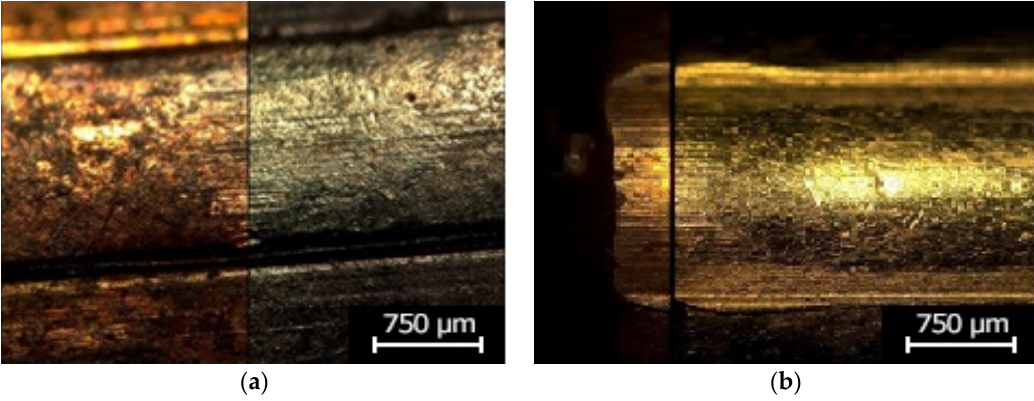
Figure 9. Images of the characteristic properties of the surface marks: ( a ) bullet and the replica coated with Au—10 nm, ( b ) bullet and the replica coated with Au—10 nm.